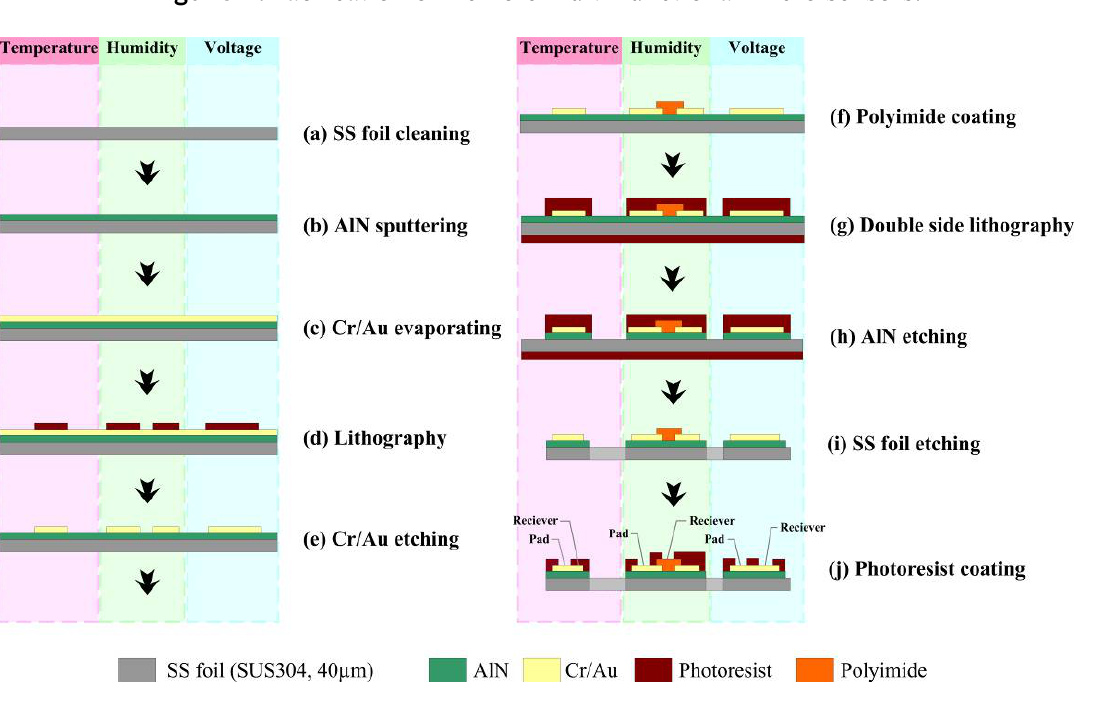
Figure 4. Fabrication of flexible multi-functional micro